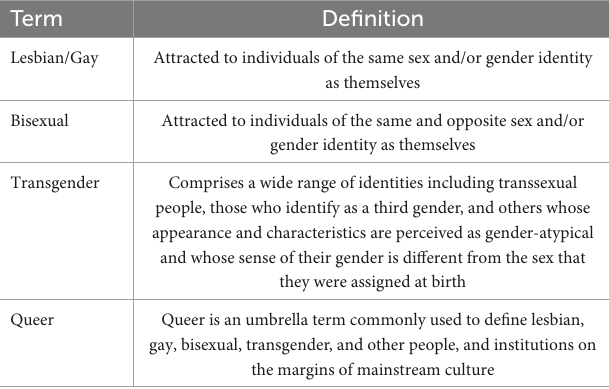
TABLE 1 Gender identity definitions as per the UNHRC (Definitions,